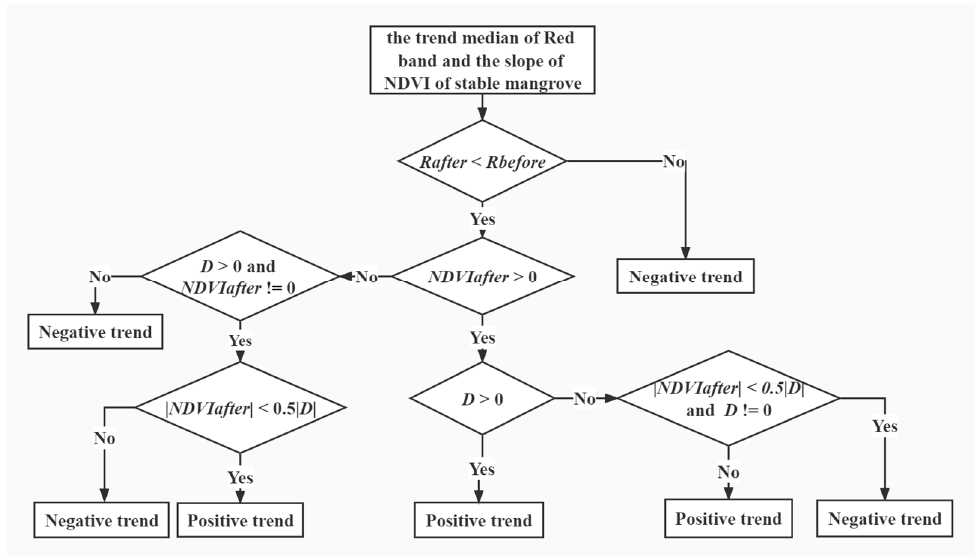
Figure 4. The criteria for judging stable mangrove positive and negative growth trends.